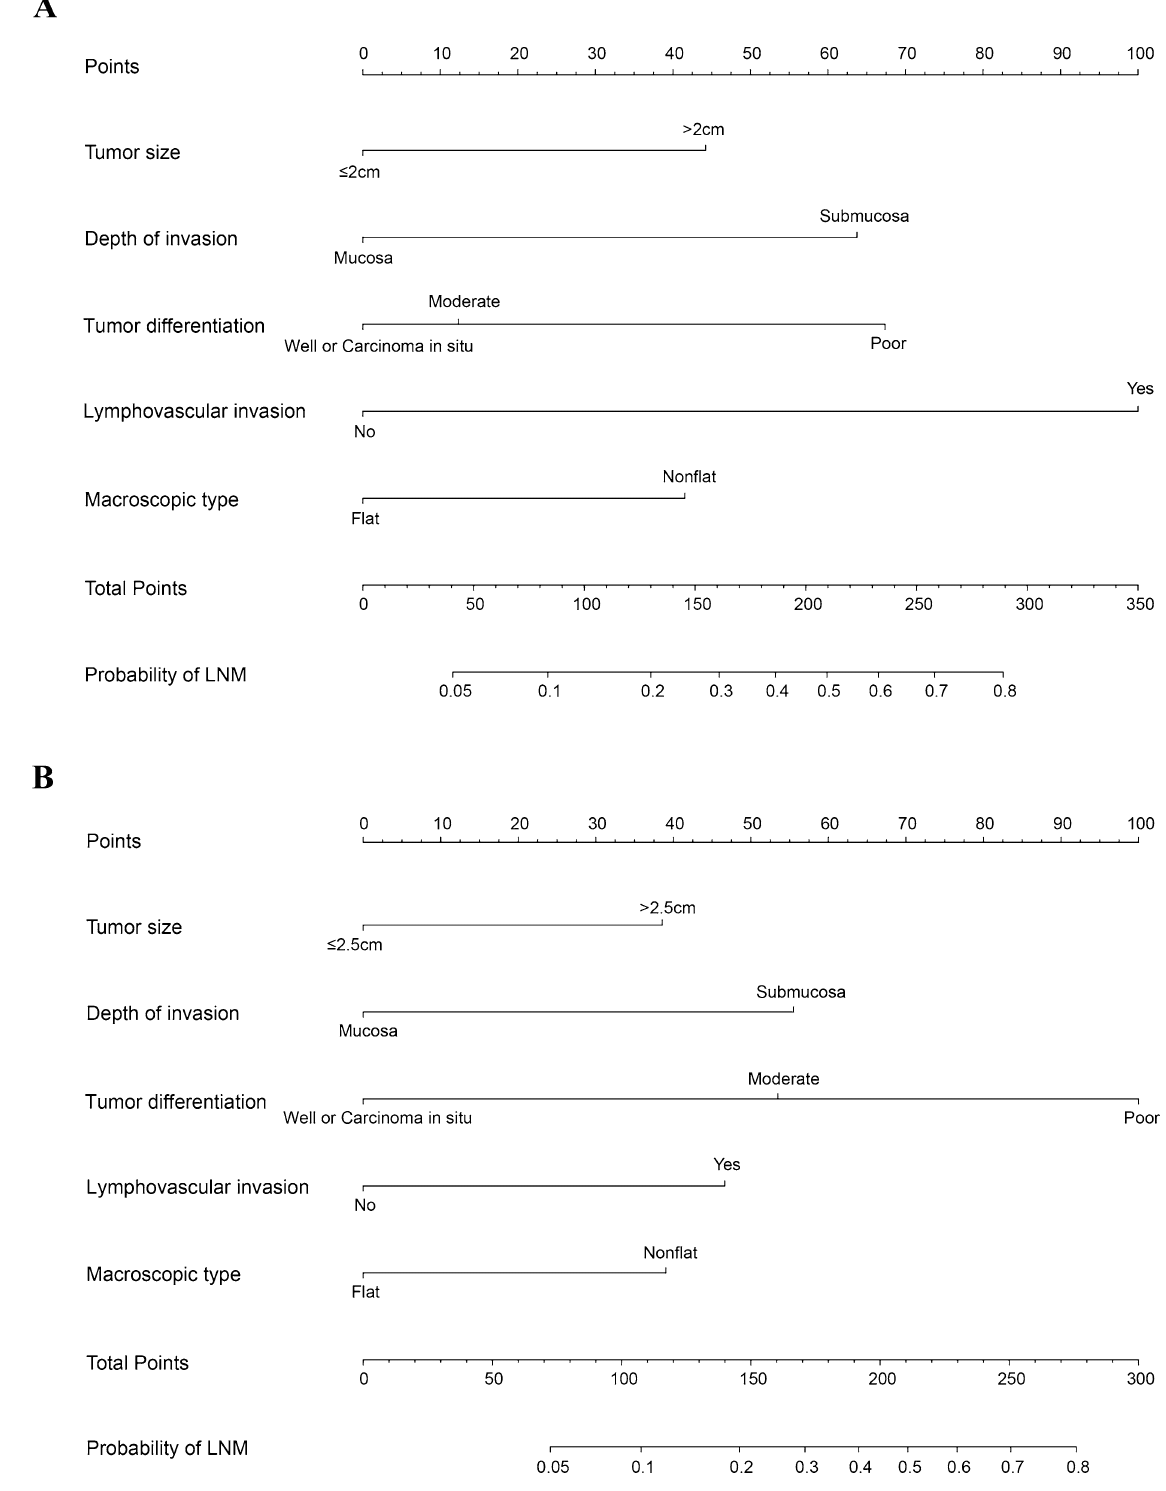
Figure 2. Nomogram for predicting the probability of lymph node metastasis in patients with superficial esophageal squamous cell carcinoma in training set ( A ) and validation set ( B ). Locate the patient’s characteristic on a variable row and draw a vertical line straight up to the points’ row (top) to assign a point value for the variable. Add up the total number of points and drop a vertical line from the total points’ row to obtain the probability of lymph node